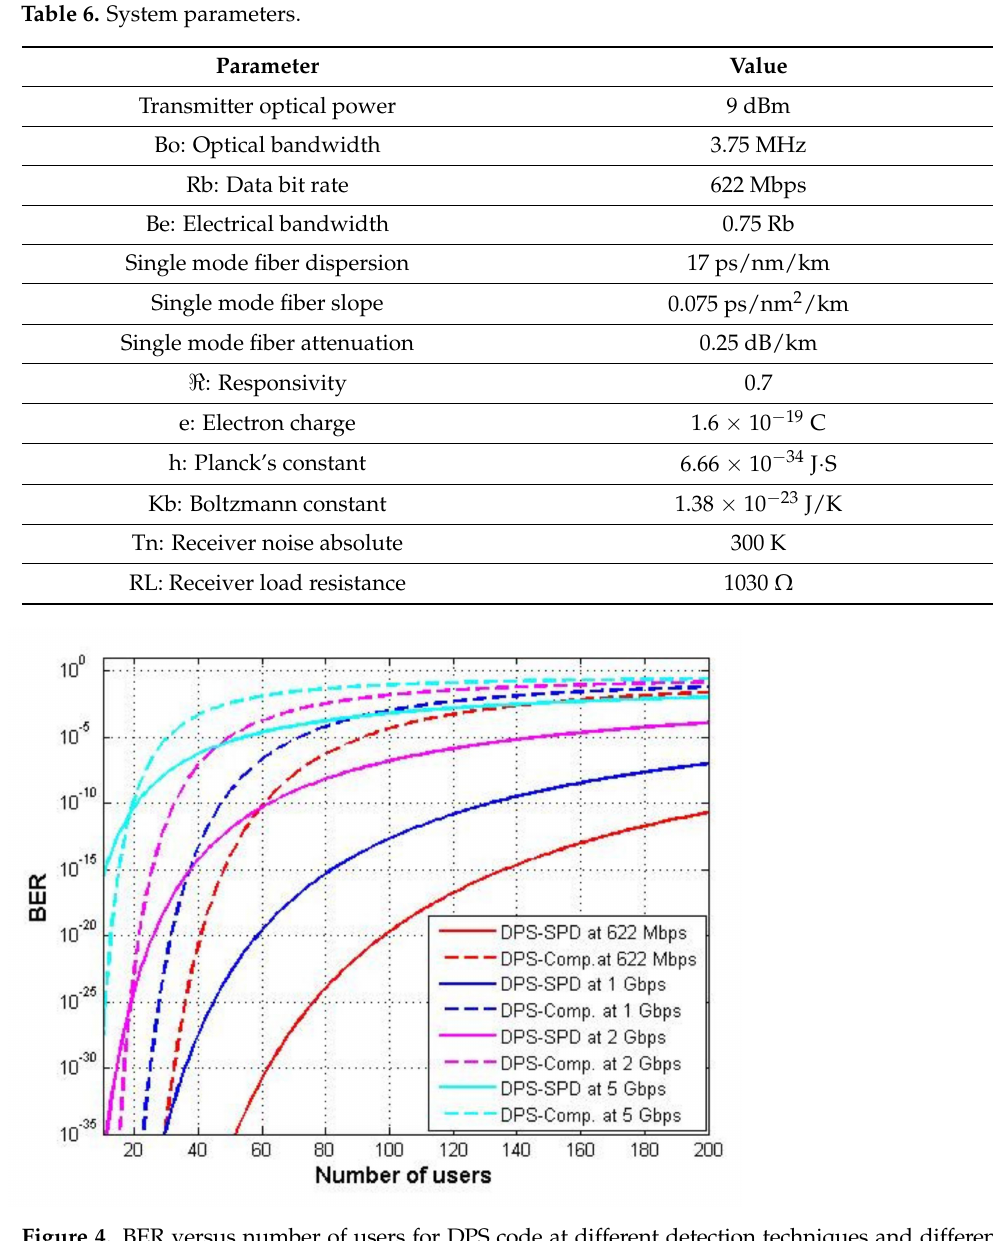
Figure 4. BER versus number of users for DPS code at different detection techniques and different bit